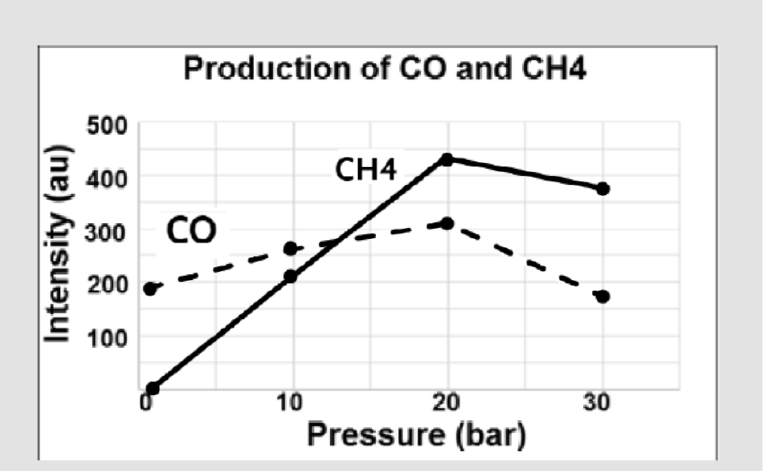
Figure 8. MS signals of the different elements of the reaction.